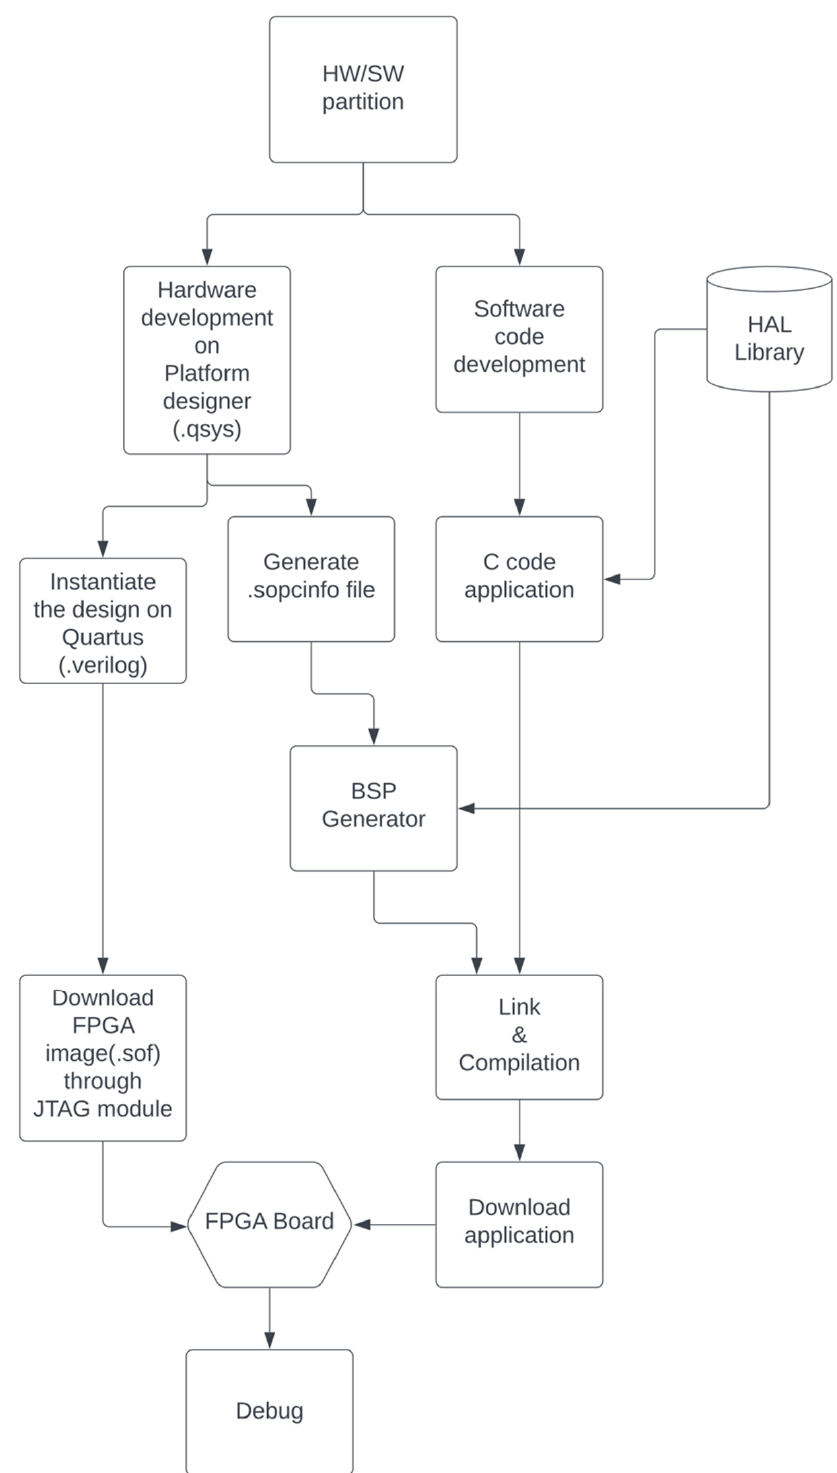
Figure 9. Common process of HW/SW co-design.